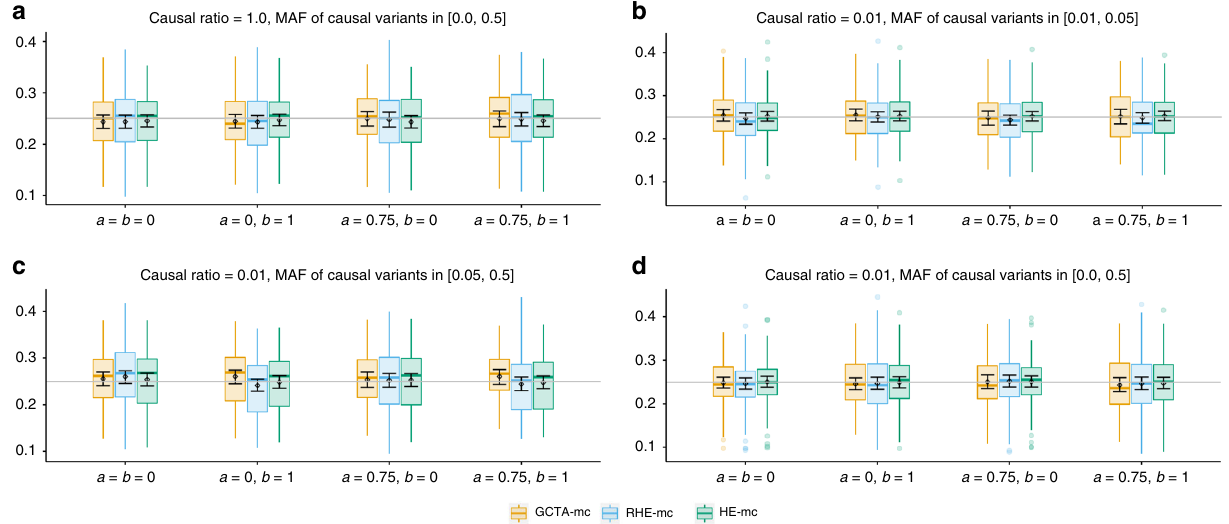
Fig. 2 Comparison of SNP heritability estimates from RHE-mc with GCTA-mc (GCTA with multiple variance components) and HE-mc (HE with multiple variance components) ( N = 10,000 unrelated individuals, M = 593,300 array SNPs). In a – d we compared heritability estimates from these methods under 16 different genetic architectures. We varied the MAF range of causal variants (MAF of CV), the coupling of MAF with effect size ( a ), and the effect of local LD on effect size ( b = 0 indicates no dependence on LDAK weights and b = 1 indicates dependence on LDAK weights (see “ Methods ” section). We ran 100 replicates where the true heritability of the phenotype is 0.25. We run RHE-mc, HE-mc, and GCTA-mc using 24 bins formed by the combination of six bins based on MAF as well as four bins based on quartiles of the LDAK score of a SNP (see “ Methods ” section). Across all different genetic architectures, the relative biases range from − 3.2% to 3.6% for RHE-mc, and from − 3.2% to 5% for GCTA-mc, and from − 2.6% to 1.45% for HE-mc. On average, RHE-mc has SEs that are 1.1 and 1.08 times larger than GCTA-mc and HE-mc, respectively. Black points and error bars represent the mean and ±2 SE. Each boxplot represents estimates from 100 simulations. Boxplot whiskers extend to the minimum and maximum estimates located within 1.5× interquartile range (IQR) from the fi rst and third quartiles, respectively. The SEs are computed from 100 simulations (note that GCTA-mc did not run successfully on all 100